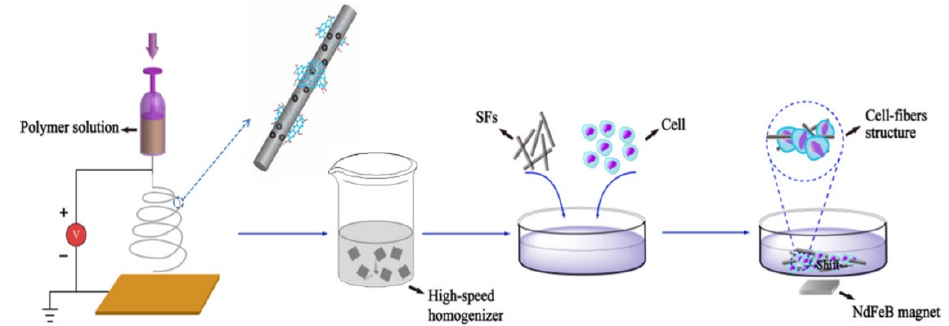
Figure 4. Cellular guidance induced by magnetic GO fibres as described by Feng et al. [158].